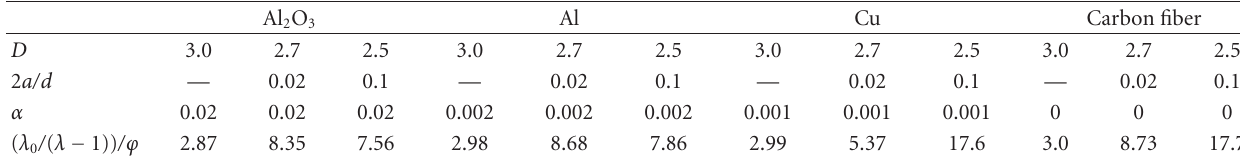
Figure 5: Diagram of aqueous chemistry as 2D plot of pH and RedOx parameters. Table 1: The enhancement of water thermal conductivity by fractal